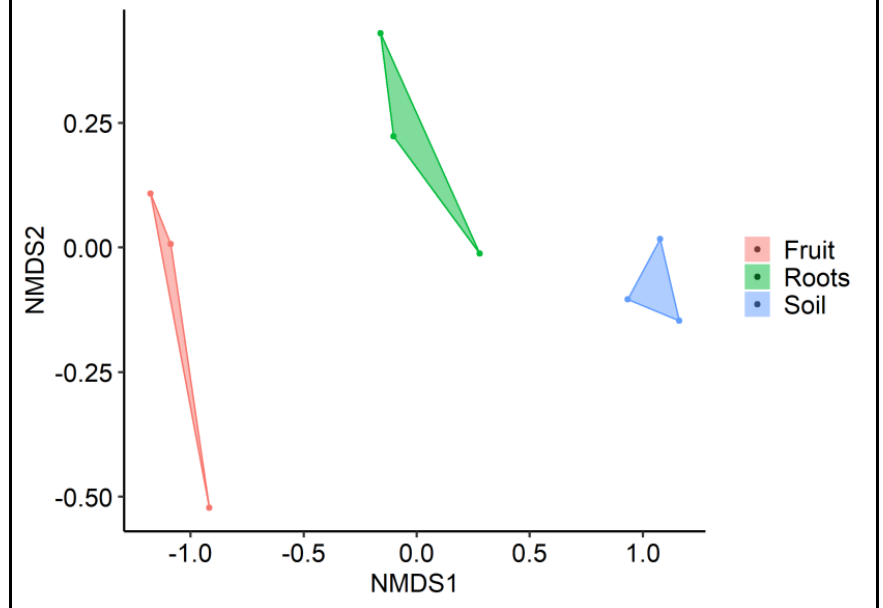
Figure 2. Inter-sample diversity variations of fruit bodies, mycorrhized roots, and rhizosphere. Non-metric multidimensional scaling (NMDS), based on Bray-Curtis, with convex hulls (Stress level: 0.02), was used.